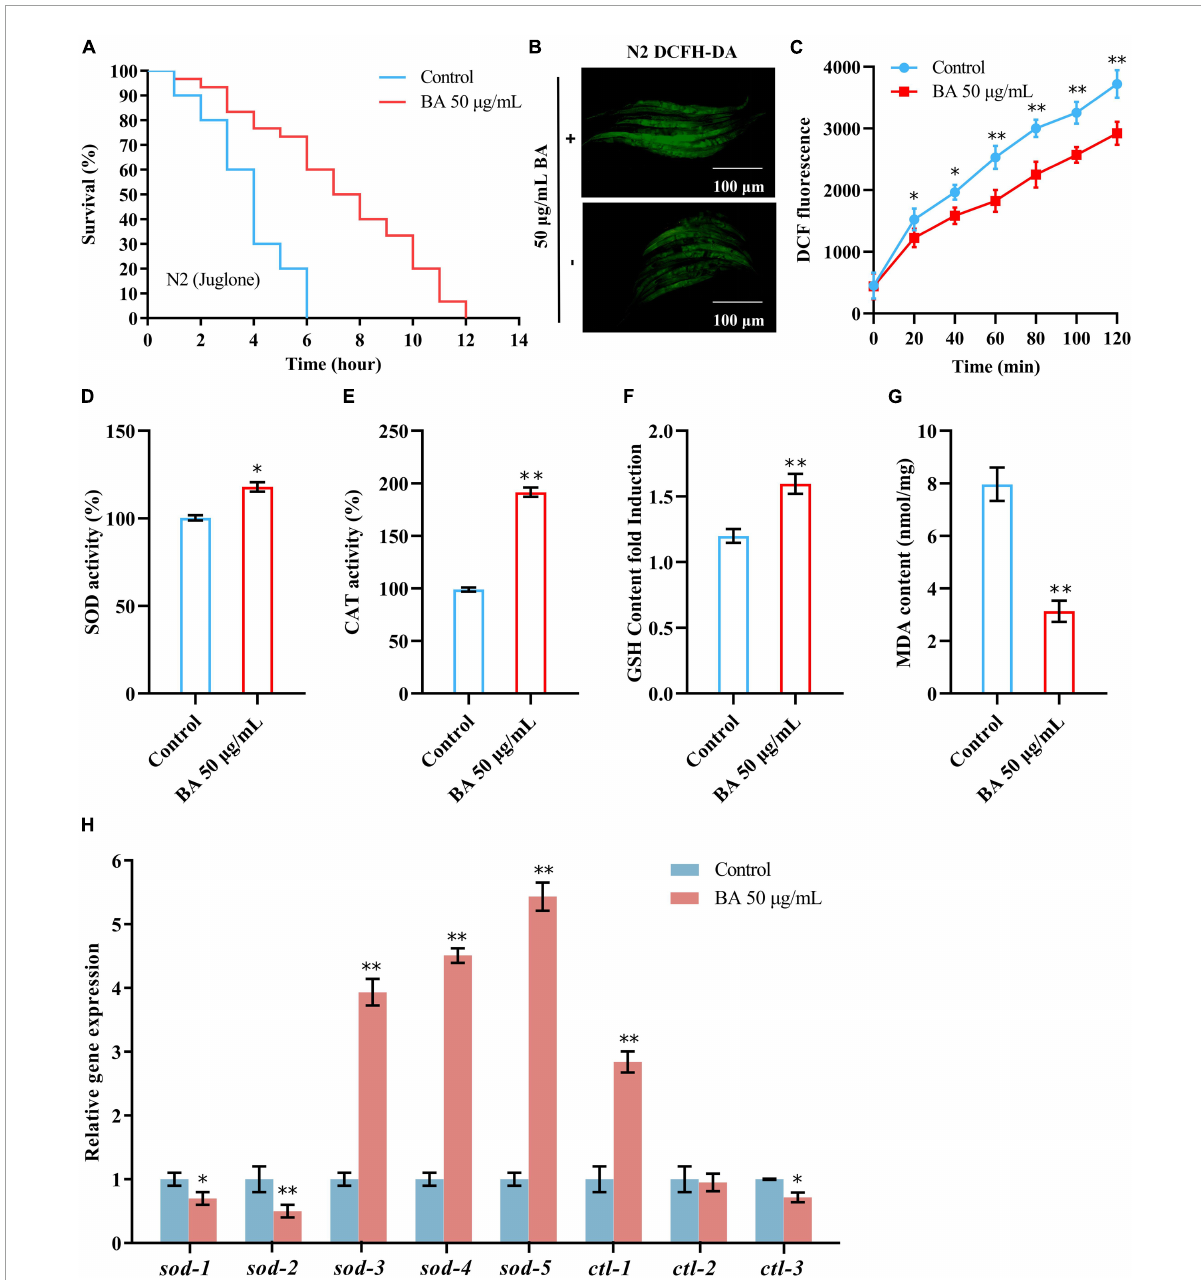
FIGURE4 Effects of betulinic acid (BA) on oxidative stress in Caenorhabditis elegans . (A) Effects of BA on juglone-induced oxidative stress. (B,C) BA decreased ROS levels in C. elegans. Representative images of DCFH-DA staining (B) and quantification of fluorescence intensity (C) were presented. (D–G) Levels of lipid oxidation: SOD activity (D) , CAT activity (E) , MDA content (F) , and GSH-Px content (G) . (H) RT-qPCR detection of the expression of antioxidant genes. Data were displayed as the mean ± SEM. For panels (C,H) , comparisons represent the One-way ANOVA followed by post-hoc Bonferroni’s test. For panels (D–G) , comparisons represent two-tailed unpaired Student’s t -test. ∗ P < 0.05; ∗∗ P <